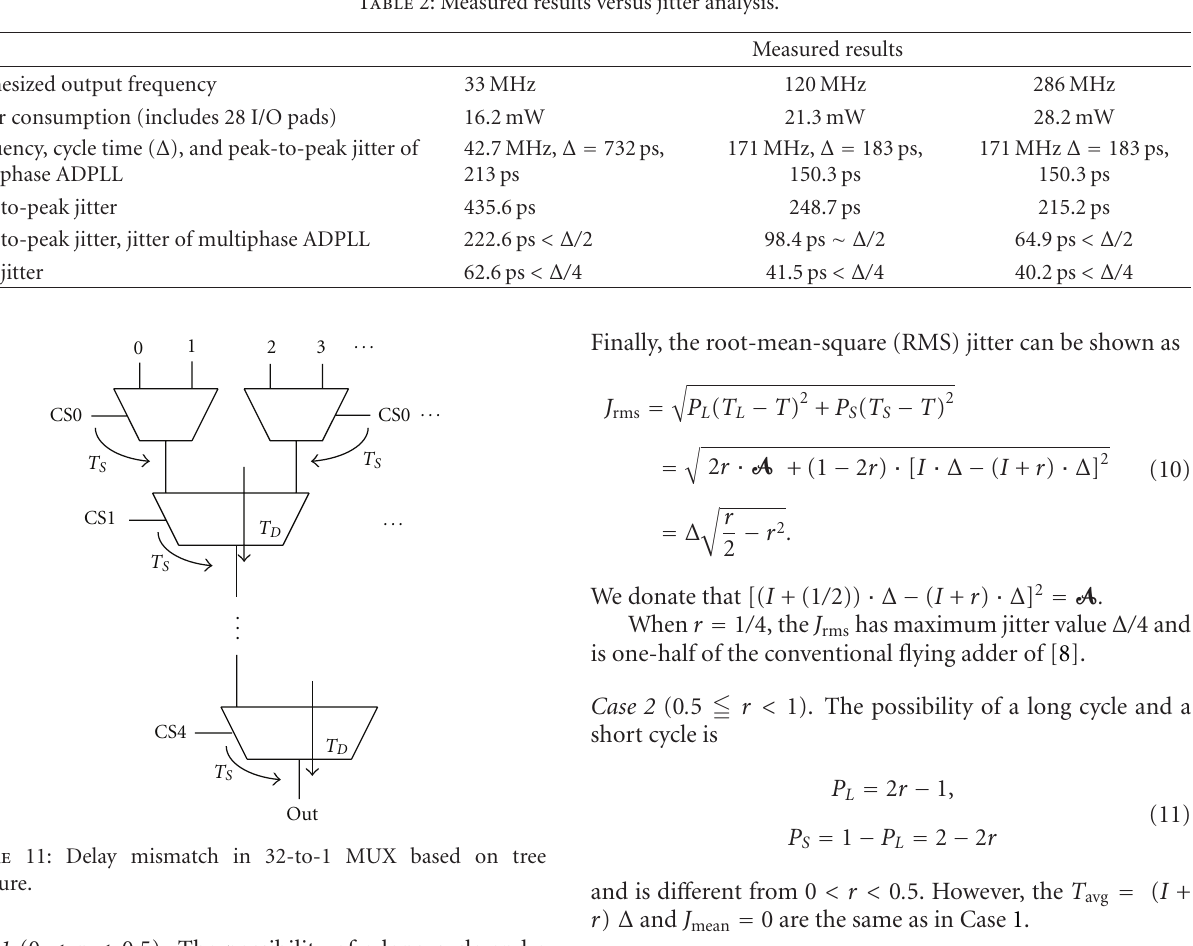
Table 2: Measured results versus jitter analysis.